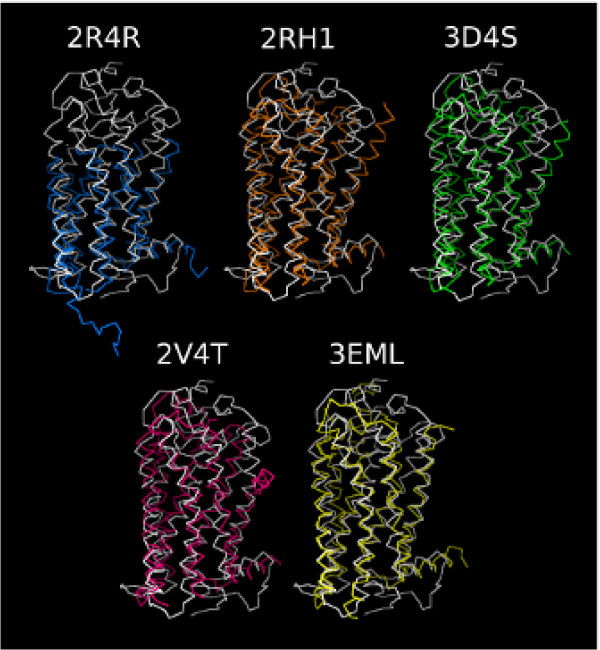
Superimposition of α-helical domains of the β2 AR-Fab, β2 AR-T4, β2AR(E122W)-T4 β1 AR and A2A R structures to GPR17 model. Ribbon representation of the β2AR-Fab (2R4R), β2AR-T4 (2RH1), β2AR(E122W)-T4 (3D4S), β1AR (2VT4) and A2AR structures after alignment of the α-helical domains to GPR17 model (in gray) are reported in cyan, orange, green, magenta and yellow respectively.